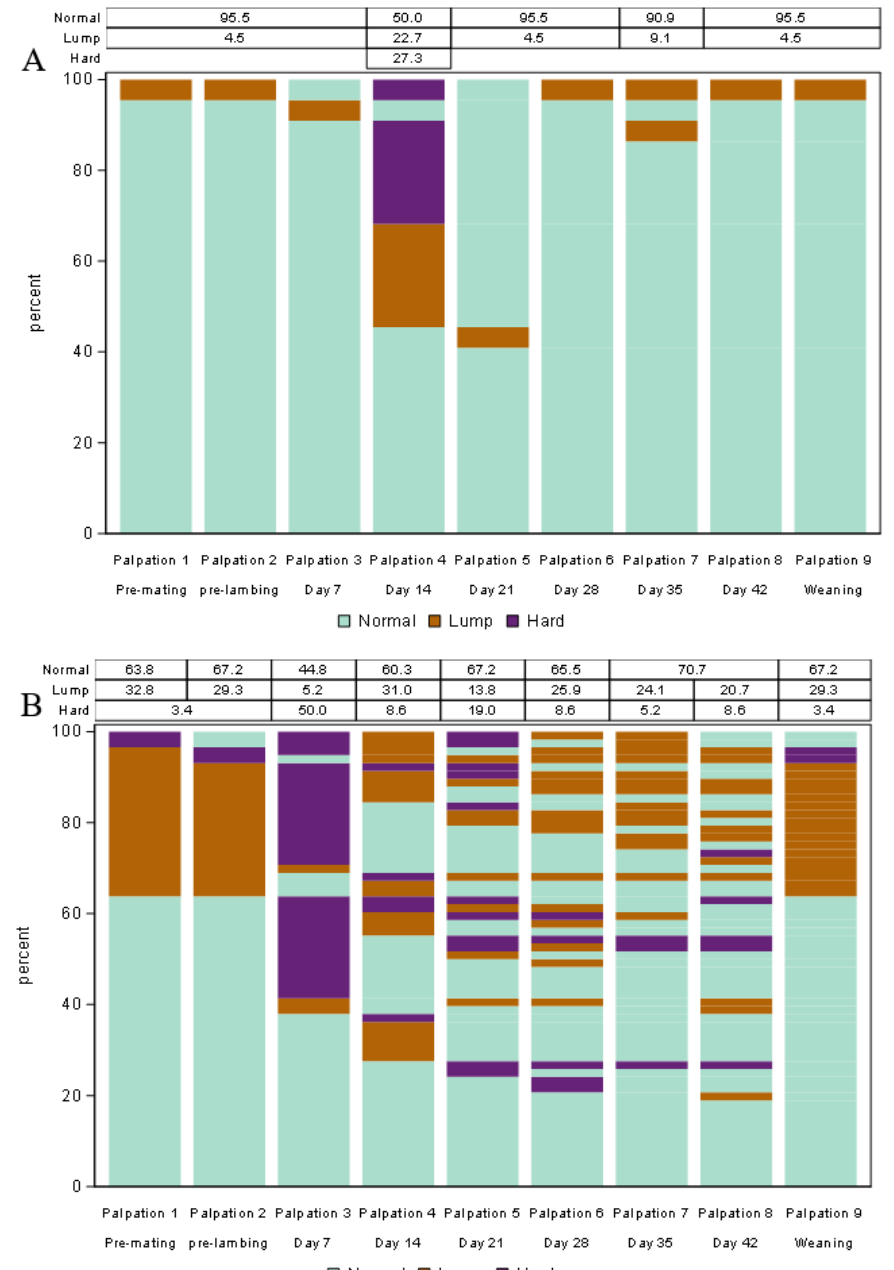
Figure 2. Lasagna plot of palpable udder half defects (hard, lump, and normal) in the first six weeks of lactation in non-dairy Romney ewes (Study B). Udder examination was undertaken at weekly intervals from 22 udder halves that had no history of defects in the previous two years (2017 and 2018); ( A ) and from 58 udder halves that had a history of defects ( B ). Note: Within each plot, each bar shows a different udder scoring event (i.e., time) while the different colours within each bar represent the defect categories. The data in the table at the top of the plot designates the percentage of each udder half defect category at each event, which corresponds to the percentage of each colour at each event. Change in defect category over time of each udder half can be tracked by following longitudinal transitions across the udder scoring events of stacked bars. Six ewes that missed the udder examination on Day 42 were excluded from the